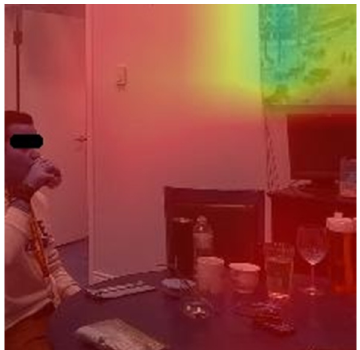
Figure 10. Example of a misclassified frame where the model is detecting the background